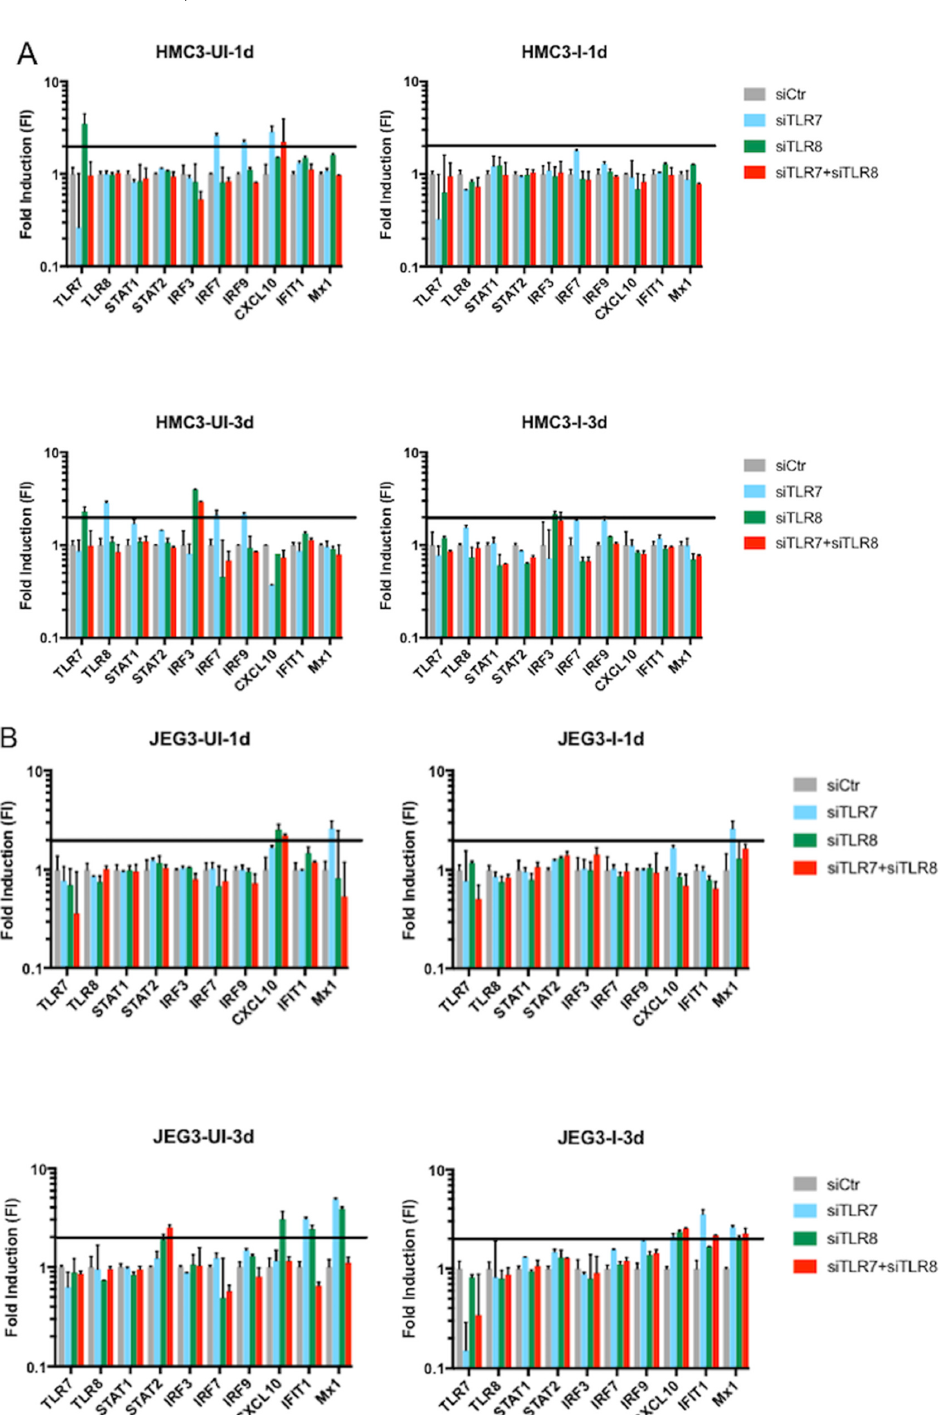
Figure 5. A comparison of the effects of a panel of siRNAs including TLR7, TLR8, TLR7 + TLR8, or scramble (control) on the expression of selected innate immune response factors. ( A ) HMC3 cells transfected with siRNA and either time-matched mock-infected (UI) or infected with ZIKV (I) at one dpi and three dpi. ( B ) JEG3 cells transfected with siRNA and either time-matched mock-infected (UI) or infected with ZIKV (I) at one dpi and three dpi. The horizontal black line marks the two-fold induction (FI) threshold in each plot.